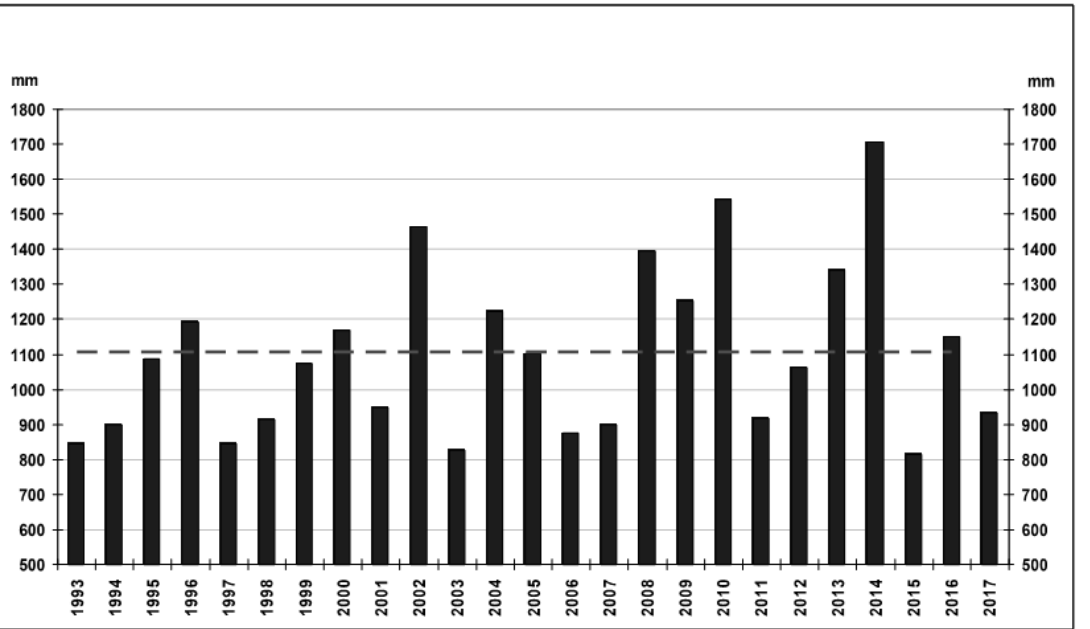
Figure 6. Mean annual rainfall from 1993 to 2017 for the Veneto Region. Weighted average of 160 rainfall stations in the period 1993–2017. The dashed line represents the average of the period as a whole [63], modified.